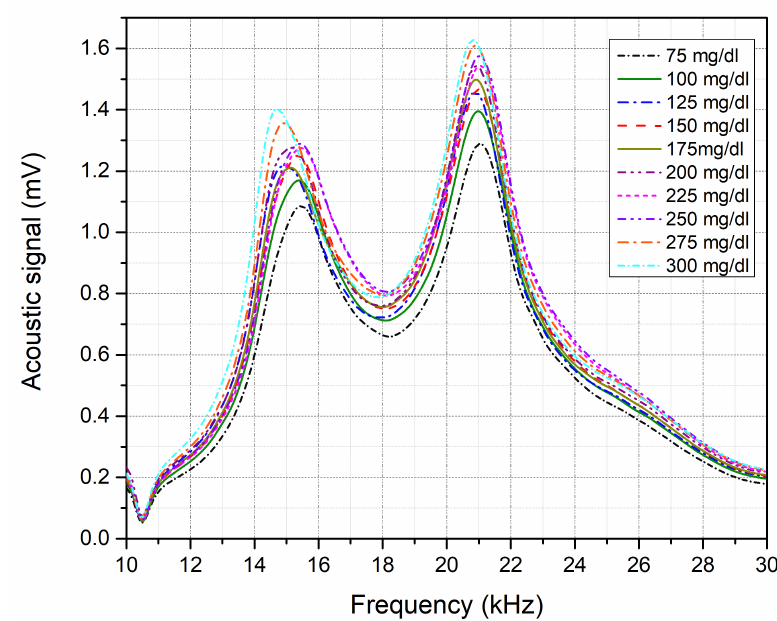
Figure 7. Acoustic spectrum for each glucose skin sample from 75 to 300 mg/dL.